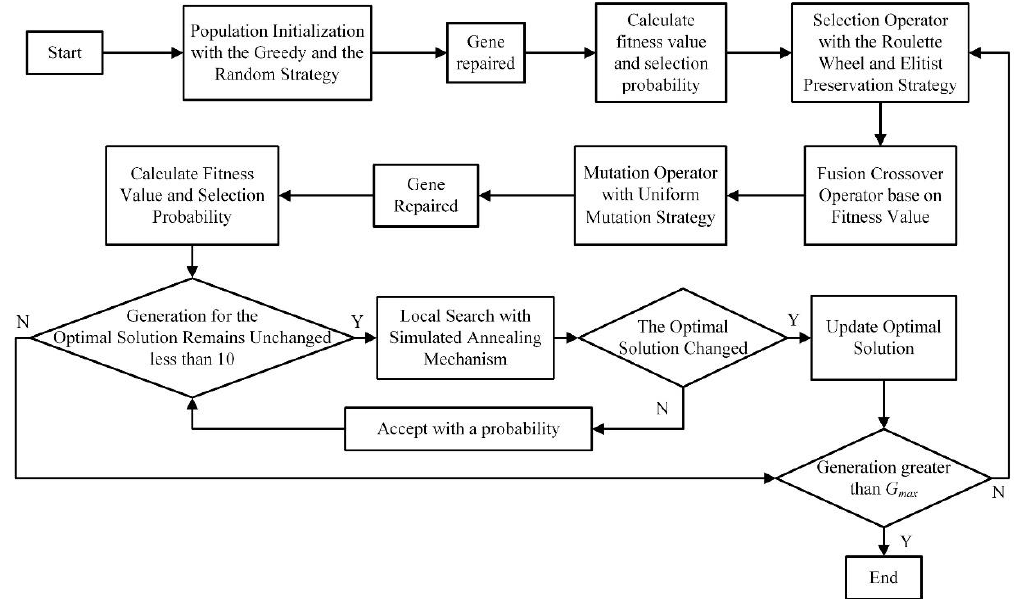
Figure 6. The flow chart of the SA–AGA. (Source: compiled by authors).